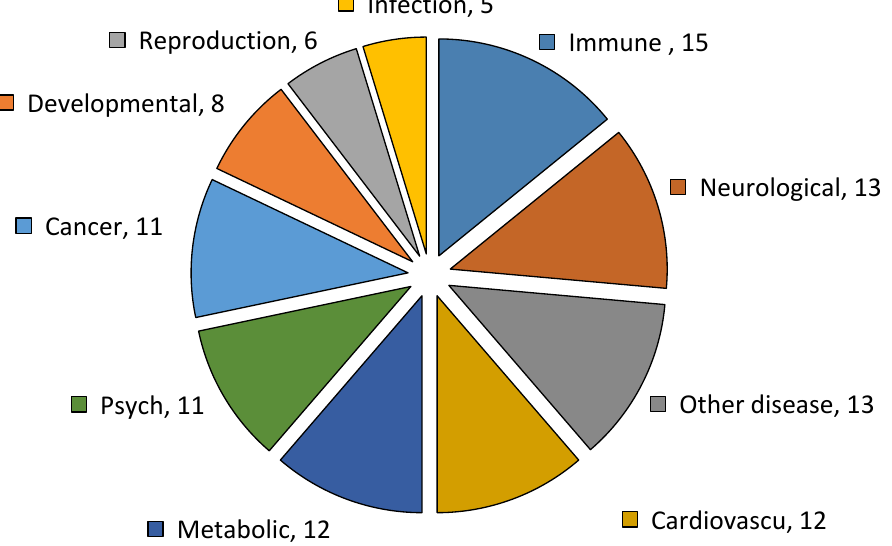
Figure 4. The pie chart of the 10 most abundant genetic association disease classes of differentially expressed genes (DEGs) showing in the parentheses the number of genes that differed between resistant and susceptible YWGs.